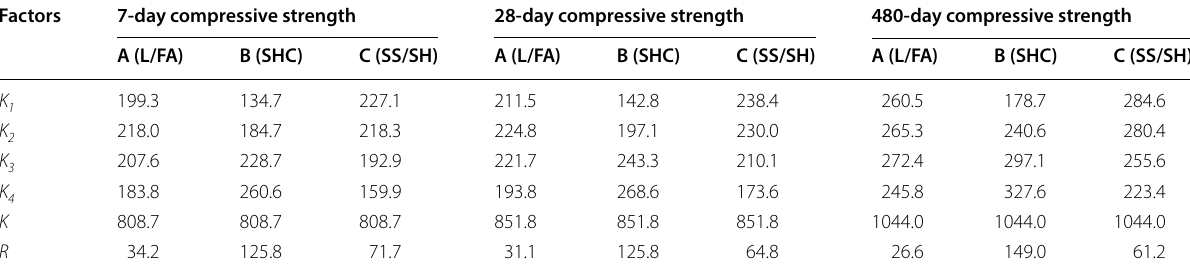
Table 8 The range analysis on initial and long-term compressive strength. Factors 7-day compressive strength 28-day compressive strength 480-day compressive strength